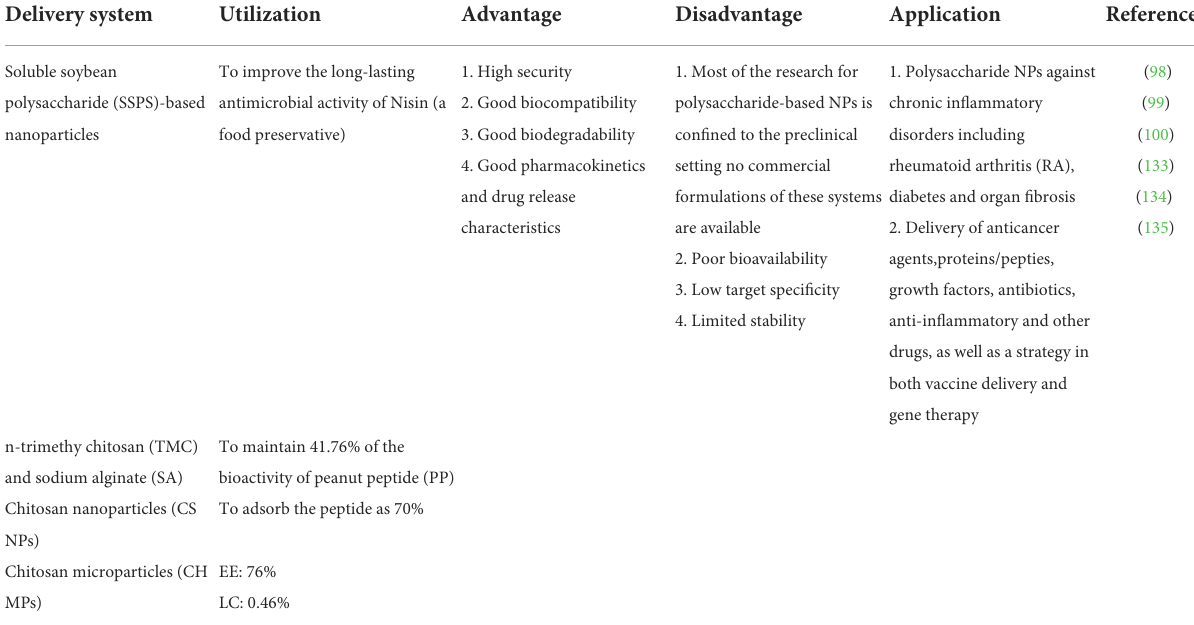
TABLE 5 Application and characterization of polysaccharide